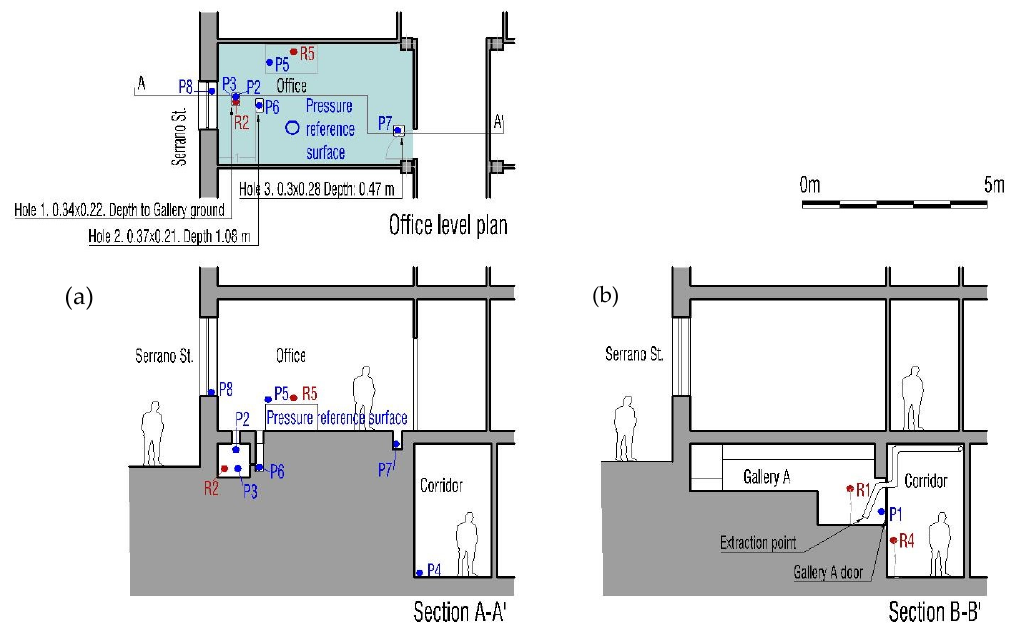
Figure 3. Positions of spaces and sensors. ( a ) Office plan and section A-A ′ , with Gallery A and corridor. ( b ) Section B-B ′ : Gallery A, passage section, and neighbor spaces. Radon sensors (R) are highlighted in red. Pressure sensors (P) are highlighted in blue.